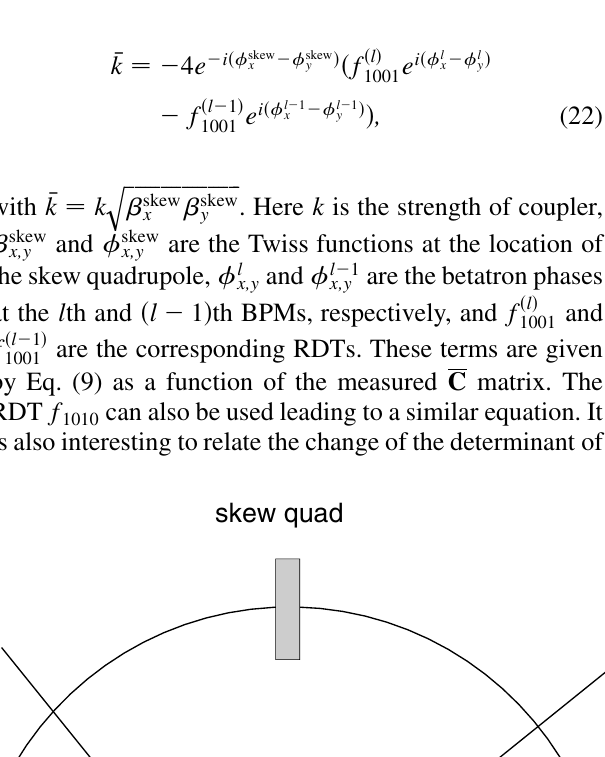
(cid:3) 28 : 266 and Q (cid:3) 29 : 212 , respectively, and (cid:3) Q (cid:3) x y min